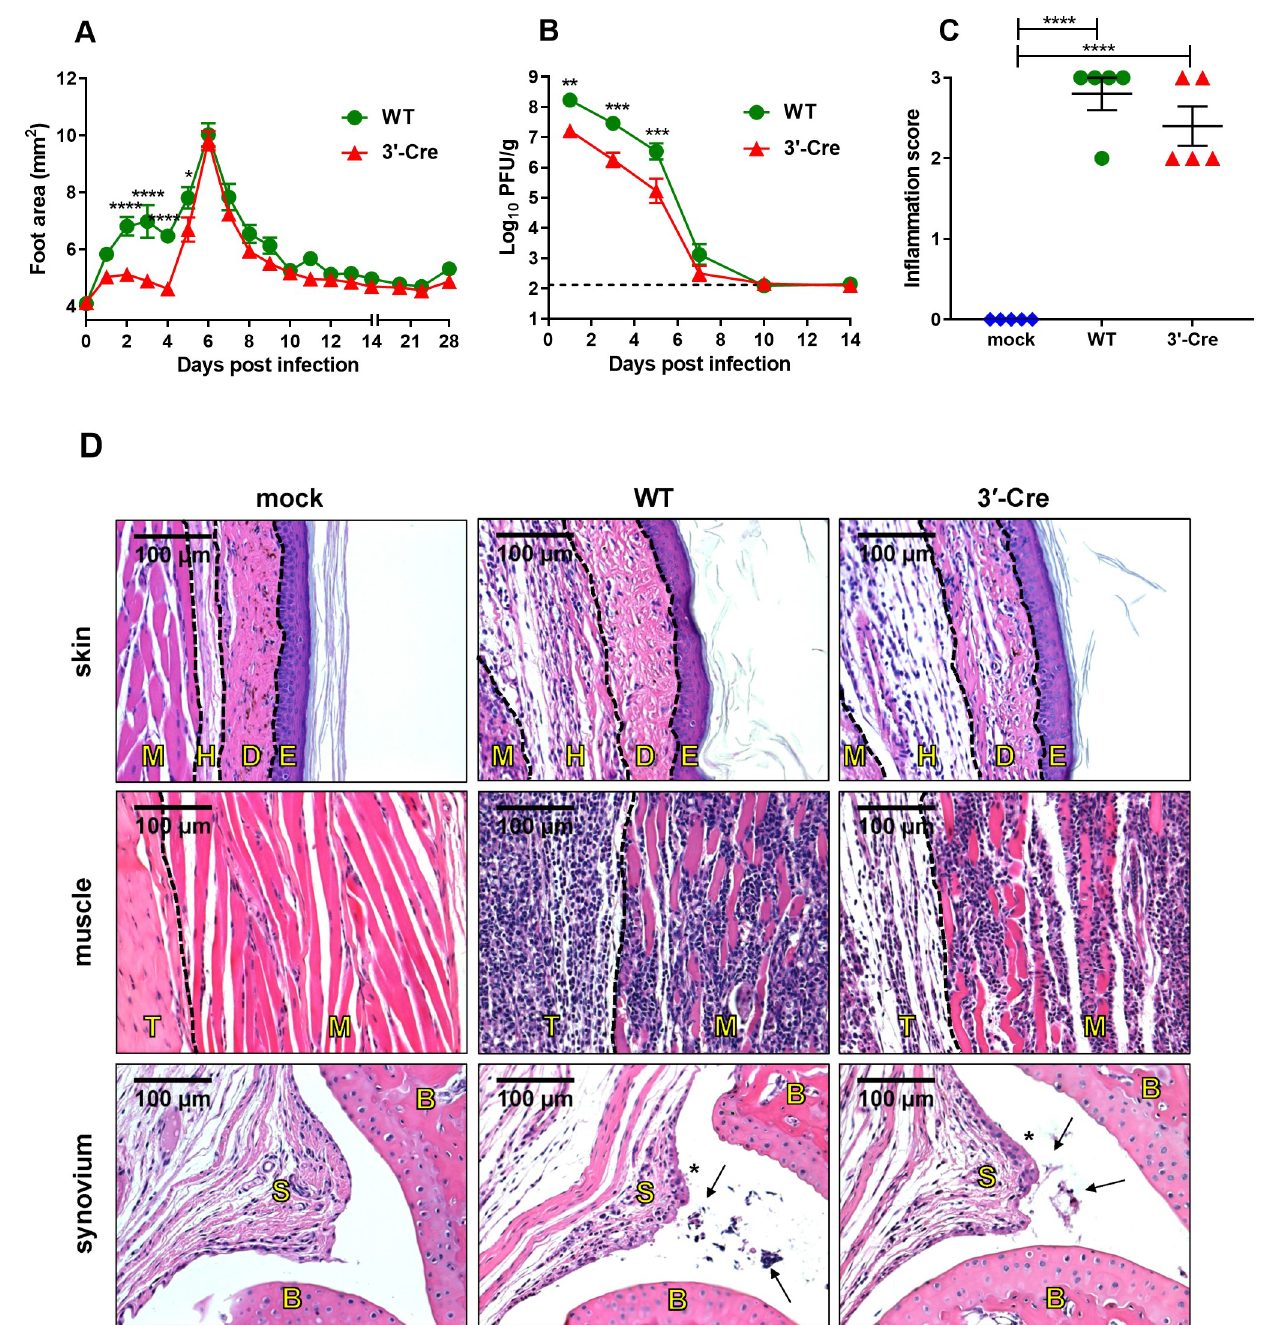
Fig 2. CHIKV-3´-Cre retains its pathogenic properties to induce acute arthritis. (A) Swelling of the ipsilateral feet of mice inoculated with 10 6 PFU of CHIKV-WT (green circles) or CHIKV-3´-Cre (red triangles). Data were pooled from two independent experiments with n = 10 for each virus. (B) Levels of infectious virus in the ipsilateral ankle during acute infection as measured by plaque assay, normalized to gram of tissue. Each time point for each virus represents 5–7 mice and were pooled from 2–4 independent experiments. The dashed line represents the limit of detection. (C-D) Mice were mock- infected (mock, blue diamonds) or infected with 10 6 PFU CHIKV-WT (WT, green circles) or CHIKV-3´-Cre (3´-Cre, red triangles), and ipsilateral ankles at 7 dpi were analyzed histologically after hematoxylin and eosin staining of sections. (C) Ankles were scored for histological damage as described in the Methods. (D) Representative images of the skin, muscle, and synovium. The skin and associated tissue are divided (from left to right) into muscle (M), hypodermis (H), dermis (D), and epidermis (E). The muscle sections are divided into tendon (T) and muscle (M). The synovium sections show synovium (S) and bone (B), with asterisks indicating synovial inflammation and arrows indicating immune infiltrates into the synovial cavity. Samples were pooled from two independent experiments with five mice for each condition. Data in A were analyzed with a two-way repeated measures (RM) ANOVA with Bonferroni’s post-test. Data in B were log-transformed and then analyzed with an ordinary two-way ANOVA with Bonferroni’s post-test. Data in C were analyzed with an ordinary one-way ANOVA with Tukey’s post-test. All error bars indicate SEM. ( � , P < 0.05; �� , P < 0.01; ��� , P < 0.001; ���� , P < 0.0001). https://doi.org/10.1371/journal.ppat.1007993.g002 PLOS Pathogens| https://doi.org/10.1371/journal.ppat.1007993 August 29,